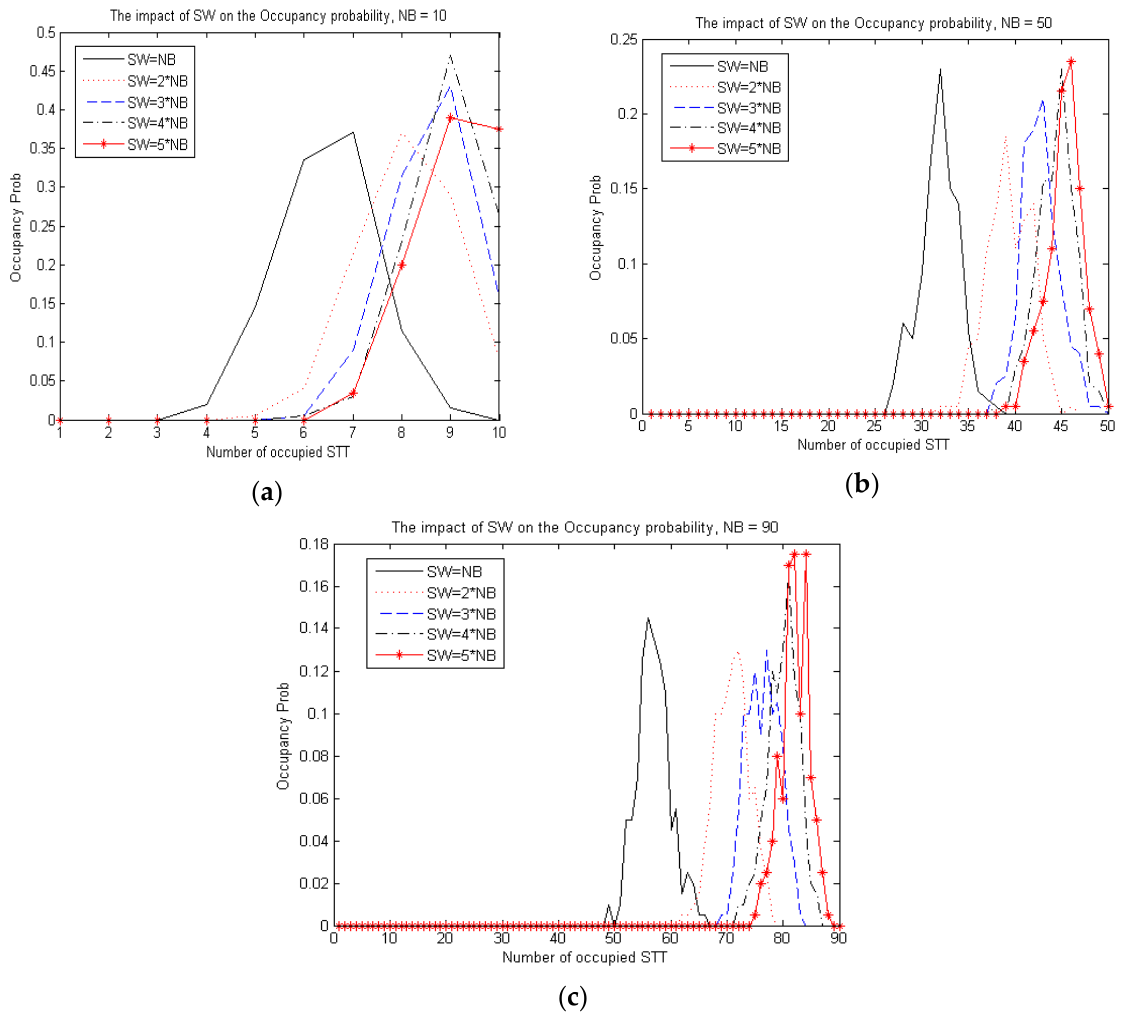
Figure 7. Impact of the SW size on the occupancy possibilities and on the HOP.